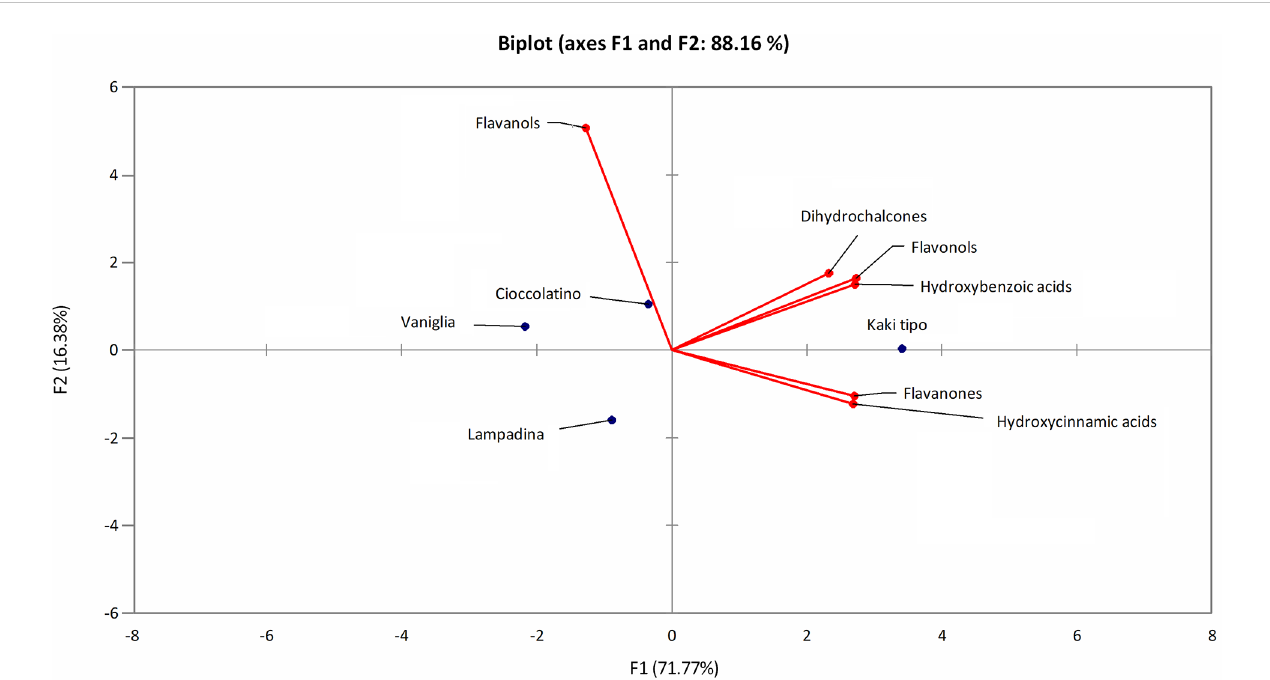
FIGURE 6 PCA score plot of polyphenols in persimmon fruits of Kaki tipo, Cioccolatino, Vaniglia and Lampadina cultivars. PCA explained about 88.2% of variability among the four cultivars, considering the fi rst two components on x and y axes. Spatial 2D distribution of samples was achieved by considering loading plots of secondary metabolites